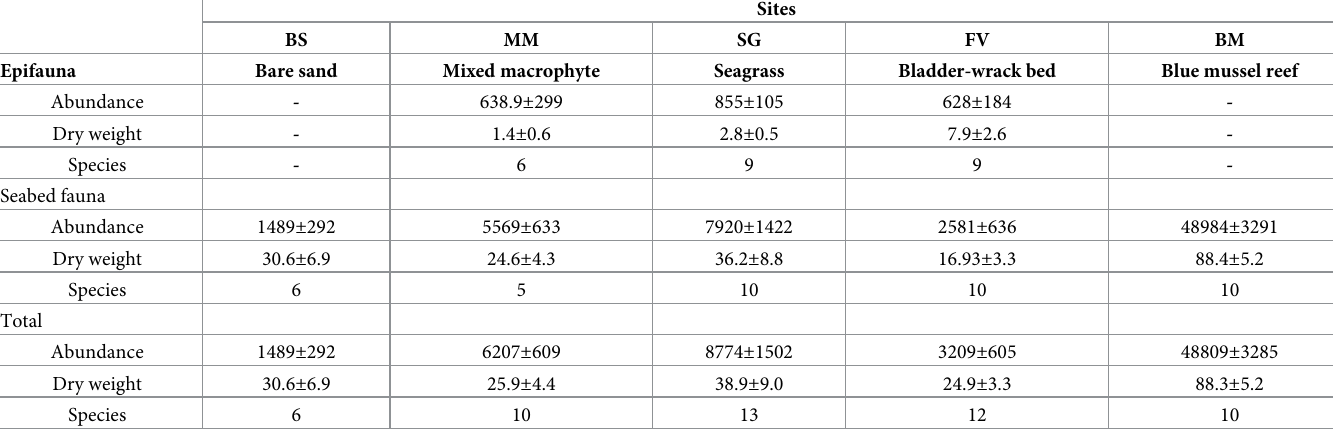
of the dominant biodiversity features when using AEC measurements is impeding a compre- hensive assessment of marine ecosystem metabolism across coastal habitats. To our knowl- edge, this is the first time that benthic biodiversity surveys across habitats have been performed exclusively upon the multidirectional AEC flux footprint characteristics ( i . e ., length, width, and area of the footprint and maximum contribution to the flux, X Table 2. Mean ( ± SE) abundance, biomass and the number of species observed at the five habitats. All the macrofauna was divided between those species associated to the macrovegetation or macroalgae ( i . e .,epifauna), and those species directly related to the seafloor substrate ( i . e ., seabed fauna), either buried in the sediment or attached to the rocky bed. Abundance (individuals m -2 ), biomass (dry weight, g m -2